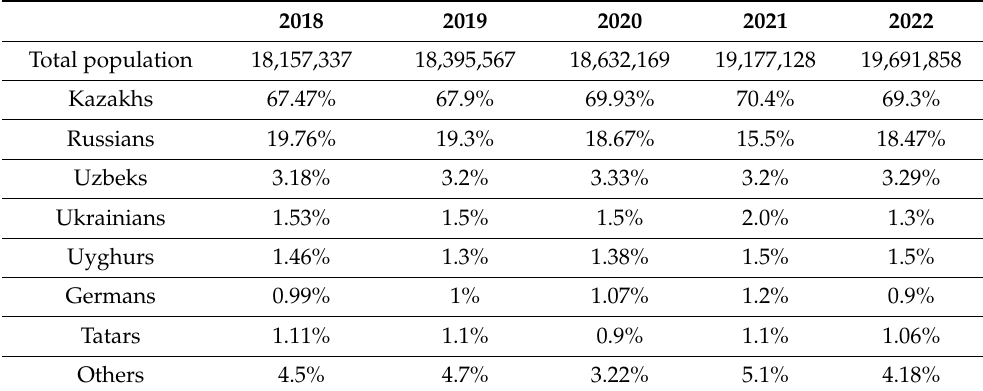
Table 1. Dynamics of demographic changes in the Republic of Kazakhstan